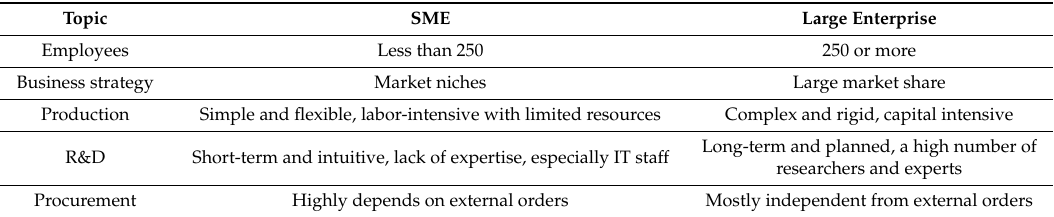
Table 1. Comparison of features between small and medium-sized enterprises (SME) and large enterprise. Topic SME Large Enterprise Employees Less than 250 250 or more Business strategy Market niches Large market